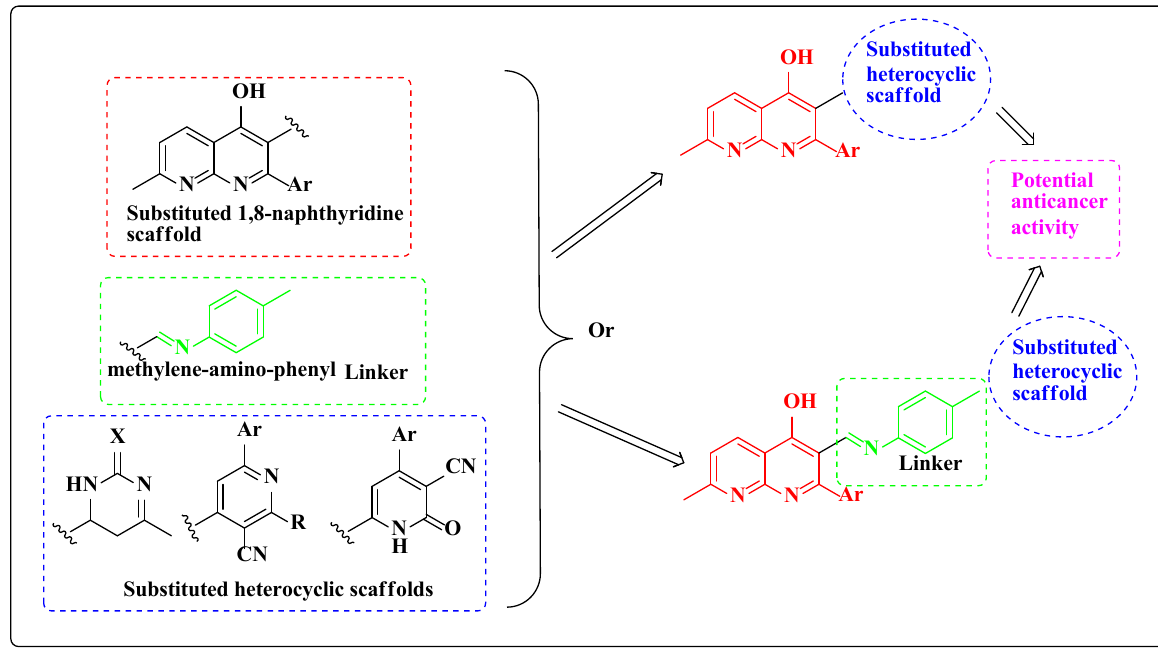
Figure 2: Design of 1,8-naphtheridine hybrid compounds as anticancer